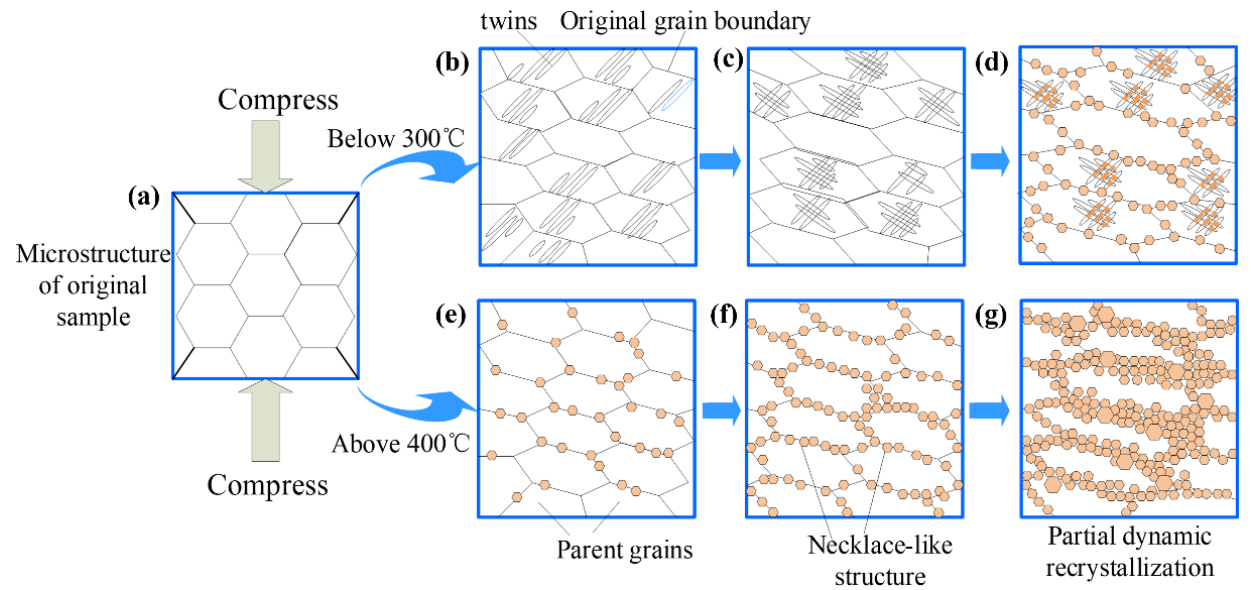
Figure 16. Schematic showing the mechanism of dynamic recrystallization during continuous compression deformation. ( a ) the microstructure of the as-solutioned specimen, ( b )the formation of lenticular twins, ( c ) twin–twin intersections, ( d ) the DRX grains nucleate at the initial grain boundaries and expand outward. ( e ) DRX grains nucleating at the original grain boundary, ( f ) the formation of the necklace-like structures, ( g ) DRX grains expand inward the original grains.